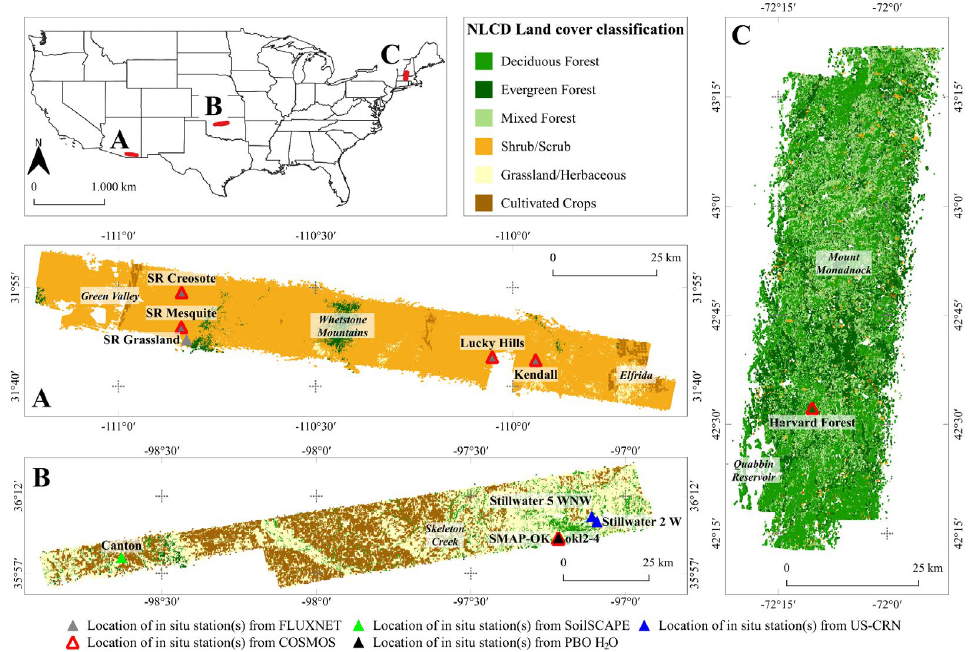
Figure 2. Overview of NLCD land cover classifications at the study areas of individual AirMOSS monitoring sites in the US with locations (triangles) of in situ measurement stations from various networks. ( A ) Walnut Gulch, AZ, USA. ( B ) MOISST, OK, USA. ( C ) Harvard Forest, MA, USA. Political state boundaries of the U.S. are from https://hifld-geoplatform.opendata.arcgis.com/. Table 1. Distribution of NLCD land cover classes at every AirMOSS monitoring site (%) (in relation to the total of all processed pixels after filtering).